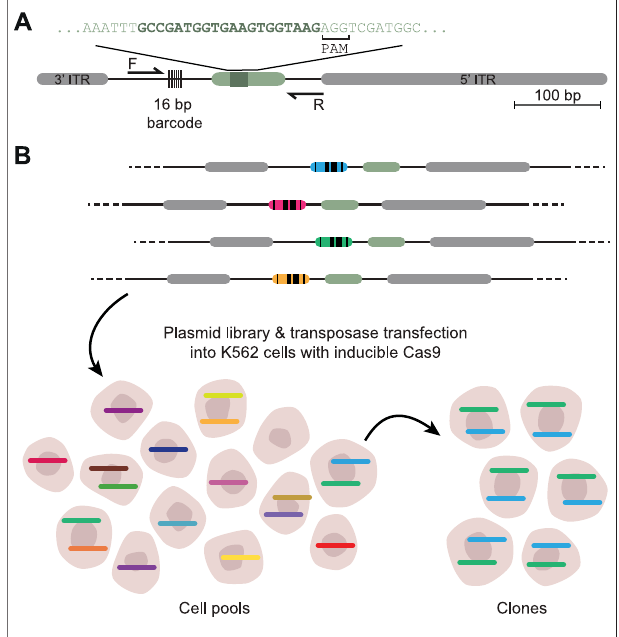
FIGURE 1 | Scheme of DSB-TRIP. (A) Scheme of the barcoded DSB reporter.In greythePiggyBacinverted terminalrepeats, inlightgreentheLBR endogenoussequencewiththe20 bpgRNAsequenceindarkgreen.Primers F and R are used to sequence the indels and the barcode. (B) RepresentationofthebarcodedlibraryandanillustrationoftheTRIPcellpools and clones with the different barcodes represented by different colours. Adapted from (Schep et al.,